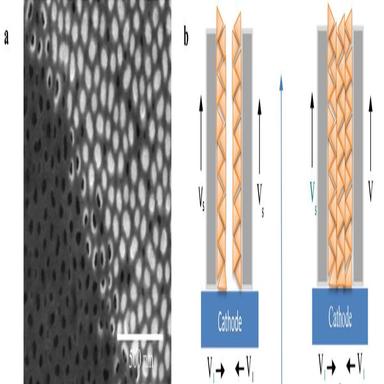
(a) SEM image of porous alumina template and nanorods where nanotubes like formed at the edge of the sample (close to O ringe) where the diffusion rate is different (b) Schematic digram of growth mechanism based on BSWG when the growth mechanism in both directions results in a gradient of crystal formation from the wall to the centre of nanorods .